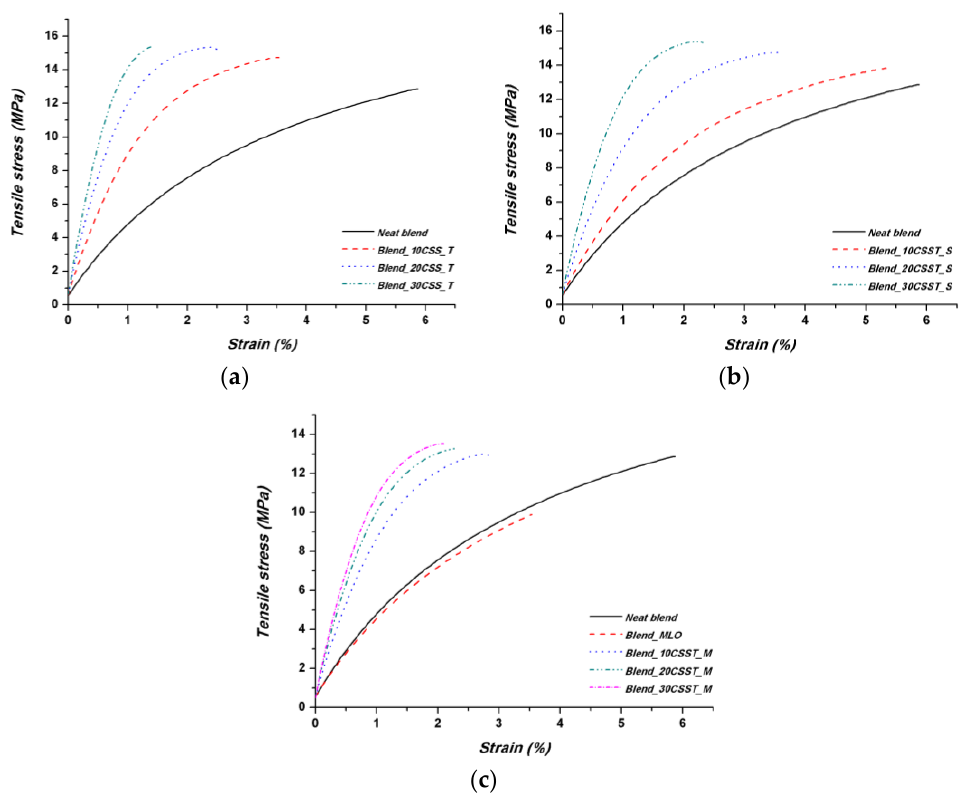
Figure 5. Typical stress–strain curves from tensile tests of PBAT/PHBV-based composites with extracted CSS ( a ); silane-treated CSS ( b ); and maleinized linseed oil (MLO) modifier ( c ) at different CSS contents.